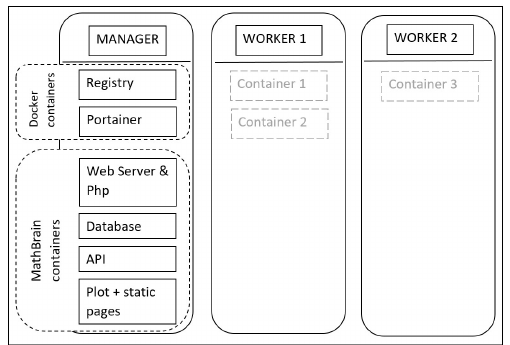
Figure 1. MathBrain